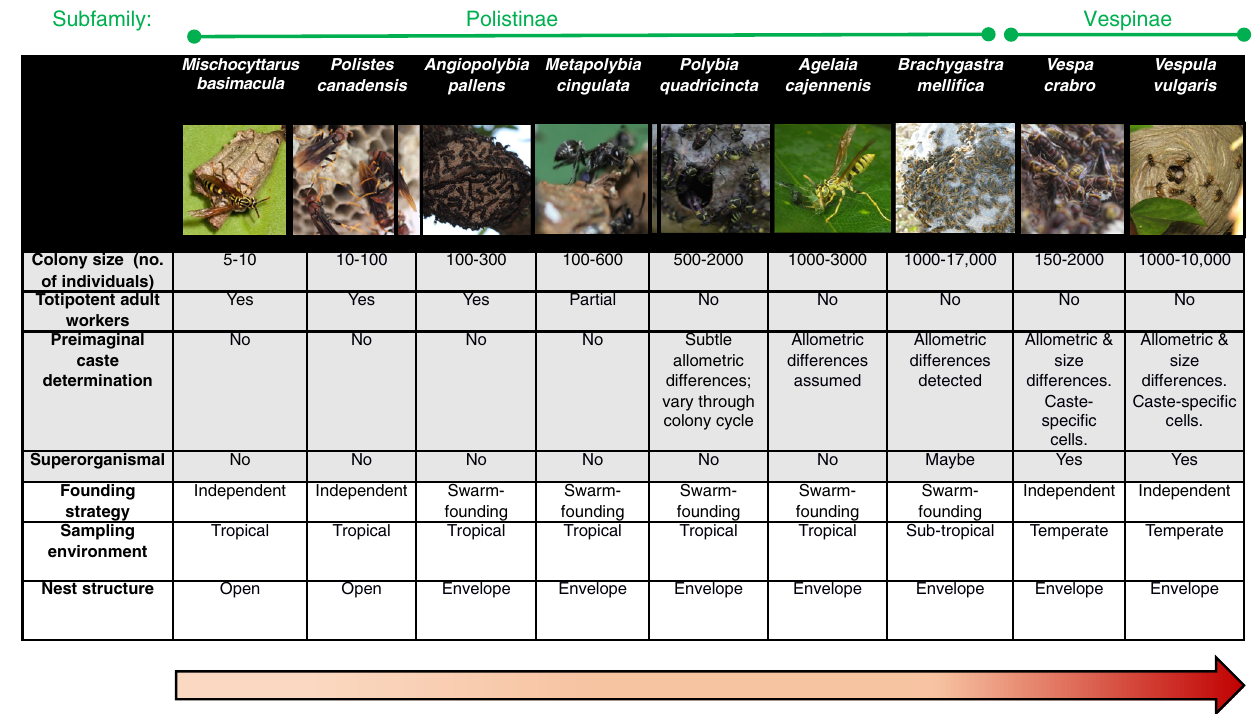
Fig. 1 | Social wasps as a model group. The nine species of social wasps used in this study, and their characteristics in social complexity and life history. The Polistinae and Vespinae are two subfamilies comprising 1100+ and 67 species of social wasp respectively, all of which share the same common nonsocial ancestor, an eumenid-like solitary wasp 92 . The Polistinae are an especially useful subfamily for studying the major transition as they include species exhibiting simple group living (with <10 individuals) of totipotent relatives, as well as species with varying degrees of more complex forms of sociality, with different colony sizes, levels of caste commitment and reproductive totipotency 93 . The Vespinae include the yellow-jackets and hornets, and are all superorganismal, meaning caste is deter- mined during development in caste-speci fi c brood cells; they also show species- level variation in complexity, in terms of colony size and other superorganismal traits(e.g.multiplemating,workerpolicing) 94 .Rankedinorderofincreasinglevels of social complexity, from simple to more complex, these species are: Mis- chocyttarus basimacula , Polistes canadensis , Angiopolybia pallens, Metapolybia cingulata, Polybia quadricincta, Agelaia cajennensis, Brachygastra melli fi ca, Vespa